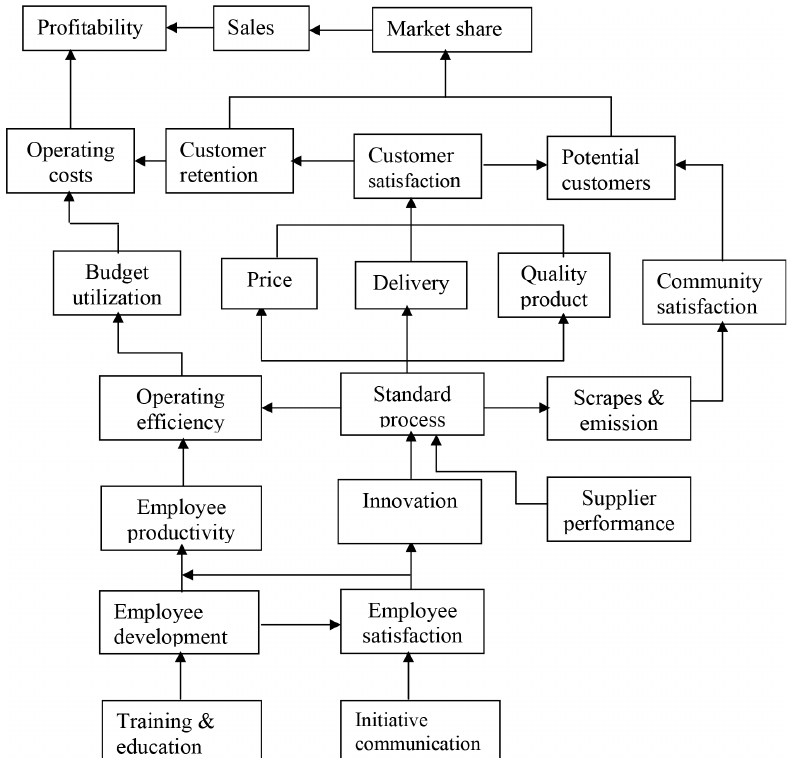
Figure 4. Strategy Map/Success Map for MCPM model development